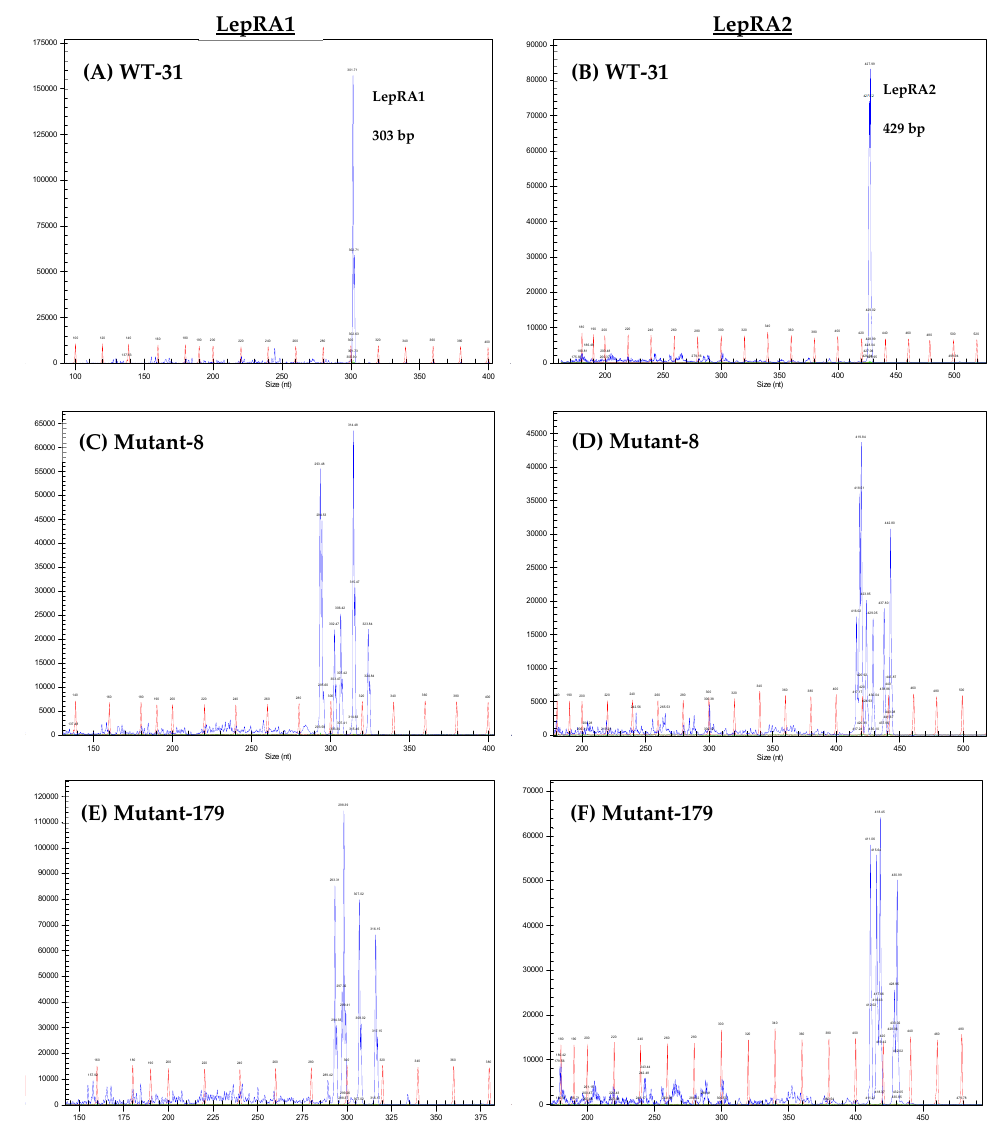
Figure 1. Representative wild type (WT) and mutant chromatograms that were generated using lepra1 and lepra2 gene specific primers for PCR amplification. Products were separated by capillary electrophoresis. Red peaks are the base pair (bp) ladder, and blue peaks represent the separated amplicons. Chromatograms show: ( A ) WT with intact lepra1 peak ~303 bp, and ( B ) WT with intact lepra2 peak at ~429 bp. Panels ( C – F ) are from example mutant fish, showing multiple peaks due to insertions/deletions, instead of a single peak for an intact gene.